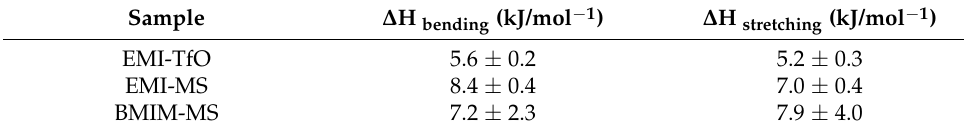
Table 2. Calculated ∆ H obtained from the linear fit regression of ln( r ) vs.